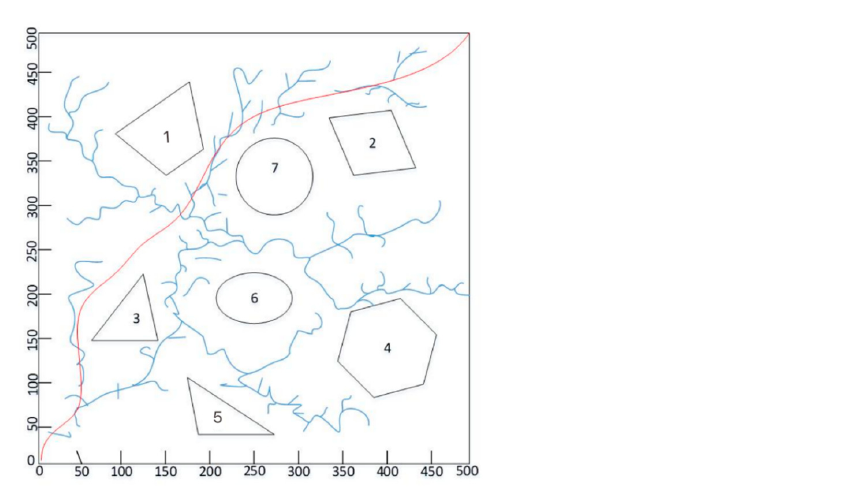
Figure 15. Comparison of number of extended nodes in scene with moderate obstacles. Figure 16. Comparison of number of extended nodes in scene with dense obstacles. From Figures 14–17, it can be seen that in each scene, the performance is affected by random growth in the space time of extension, meaning that the number of extended nodes based on both the RRT and AV-RRT is bigger. However, the latter algorithm is more stable than the former, and the time of extension of extended nodes based on the AV-RRT is smaller compared to RRT, especially in the scene with sparse obstacles, which is caused by dynamic step size.